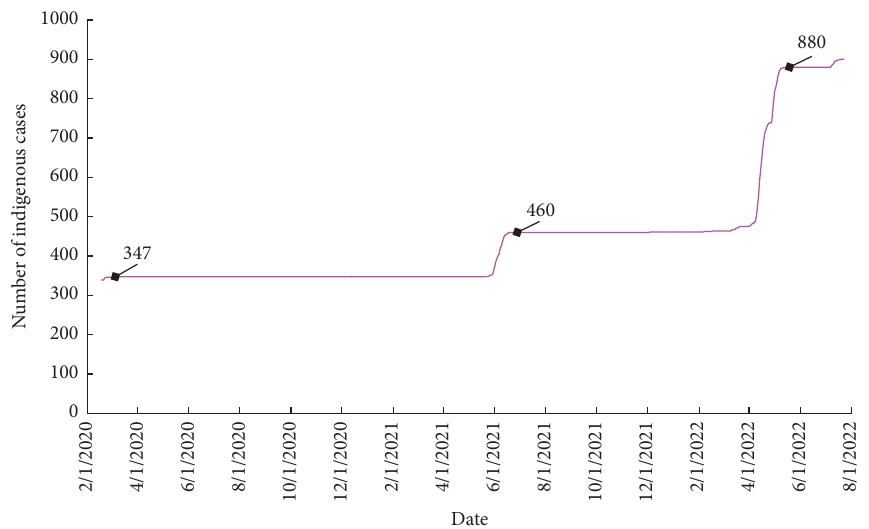
Figure 3: Cumulative number of confrmed cases in Guangzhou from February 2020 to July 2022.